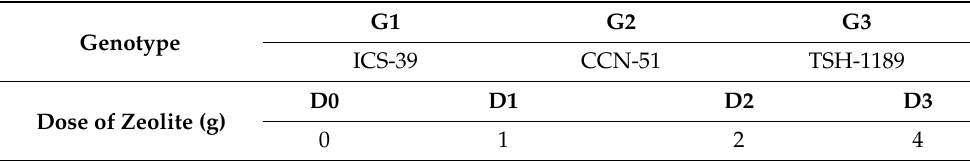
Table 2. Labels used for the description of the treatments on each